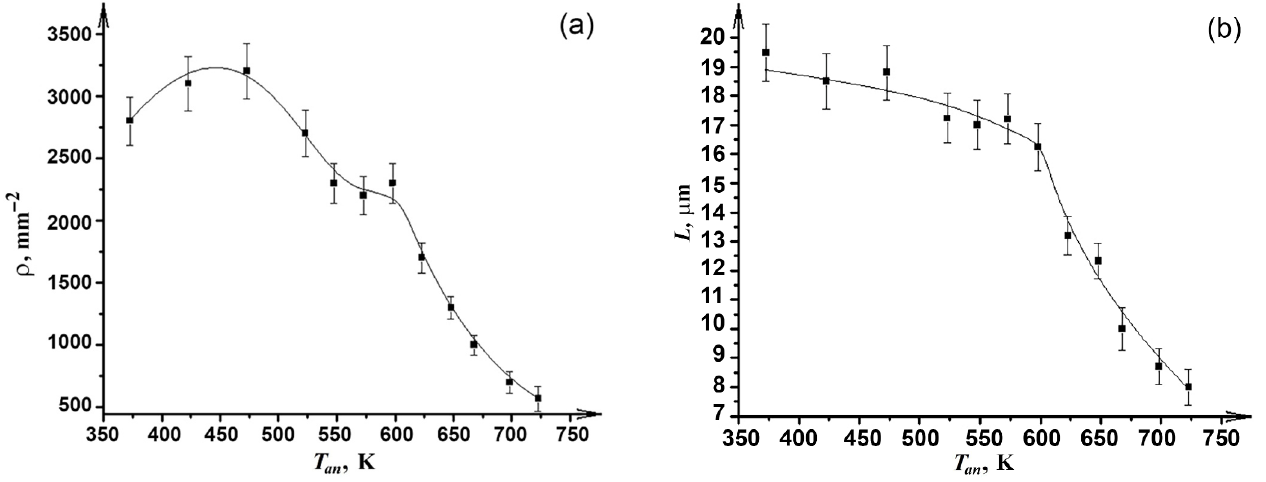
Figure 4. Local plasticity of Fe 60.8 Co 20.2 B 14 Si 5 AA as a function of annealing temperature: ( a ) surface density of plastic deformation zones; ( b ) length of shear